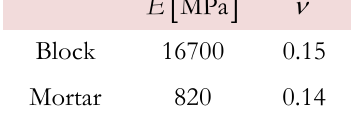
Table 1: Components mechanical properties.